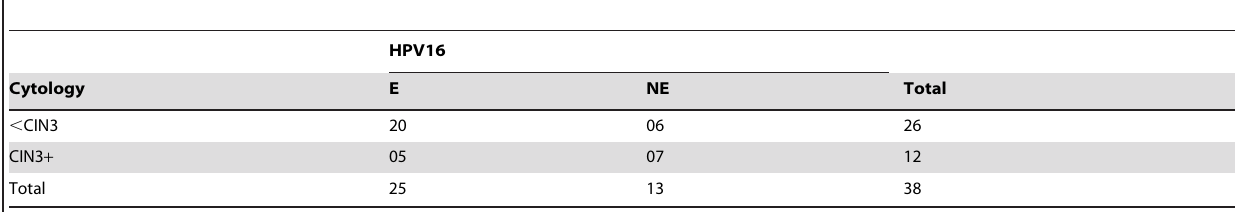
Table 1. HPV16 variant distribution by diagnostic